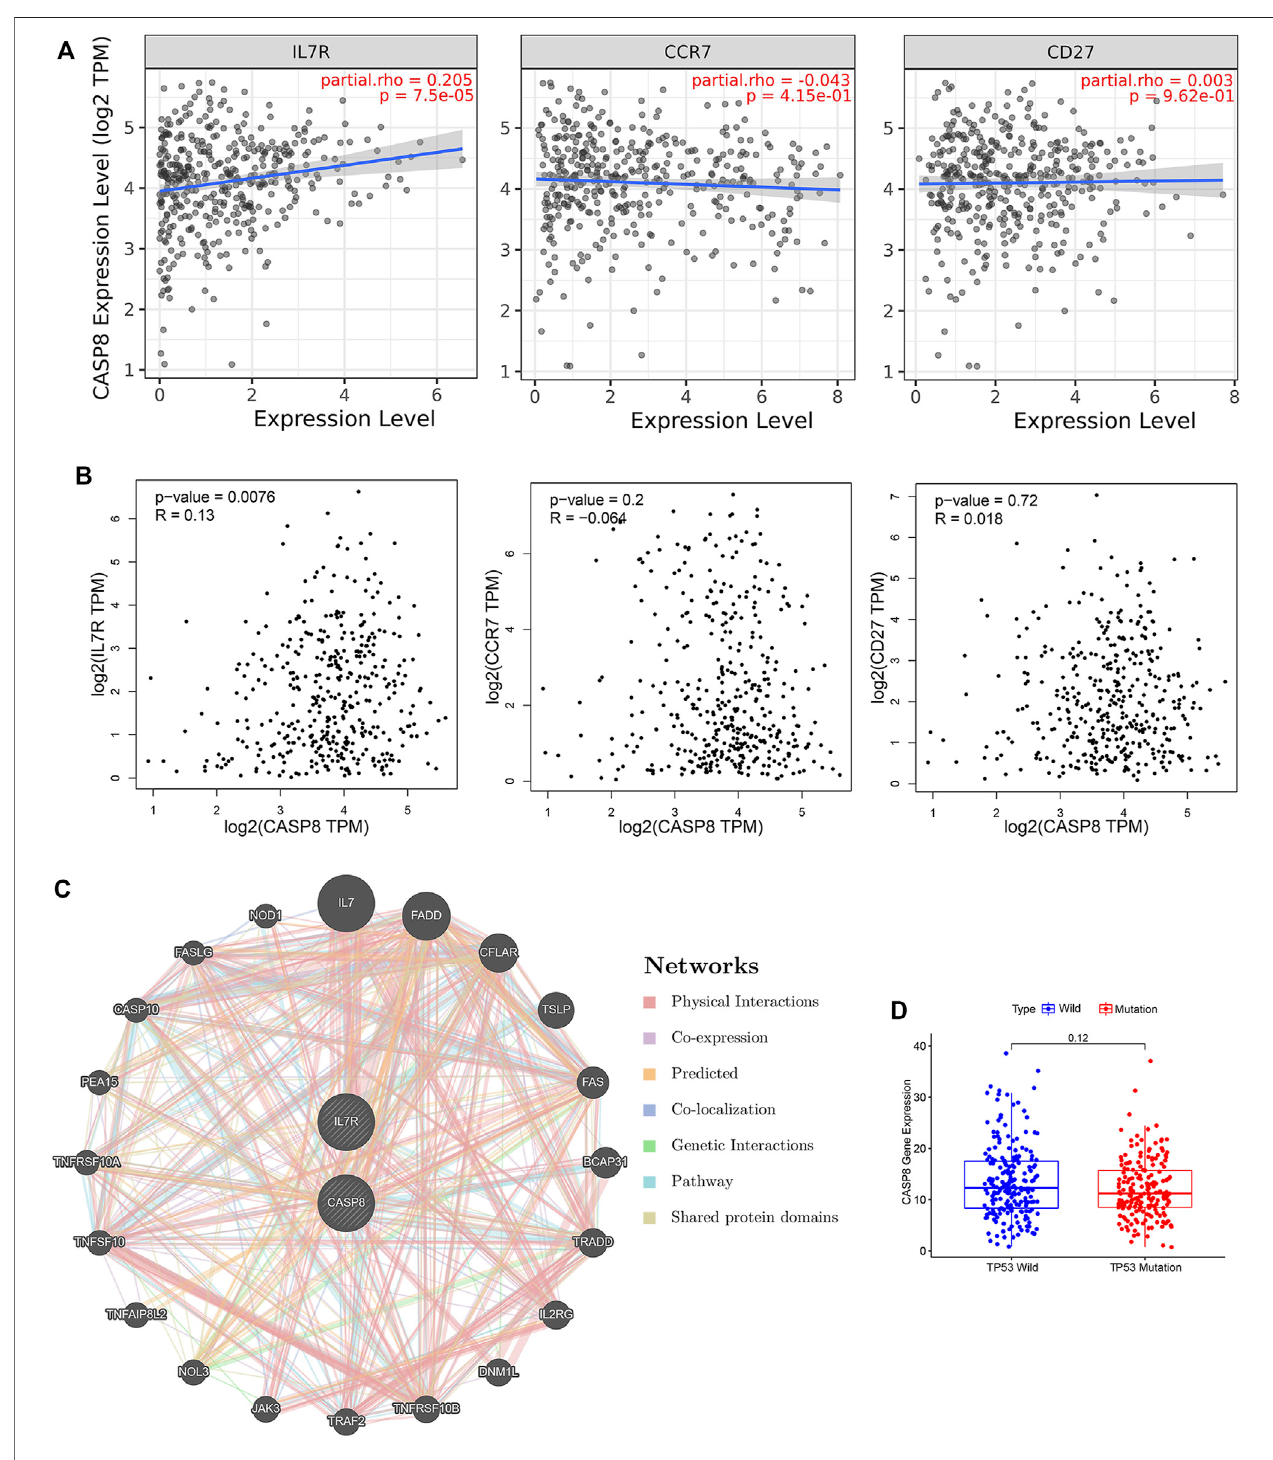
FIGURE 7 | Relationship of CASP8 with cell surface markers of activated CD4+ memory T cells in bladder urothelial carcinoma (BLCA). The correlation between CASP8 and IL-7R, CCR7 and CD27 based on (A) the TIMER and (B) GEPIA databases. (C) Gene-to-gene network analysis of CASP8 was constructed using the Metascape website. (D) The expression of CASP8 in the BLCA samples with wild-type or mutations in TP53. CCR7, C-C chemokine receptor type 7; CD27, cluster of differentiation 27; IL-7R, interleukin seven receptor.